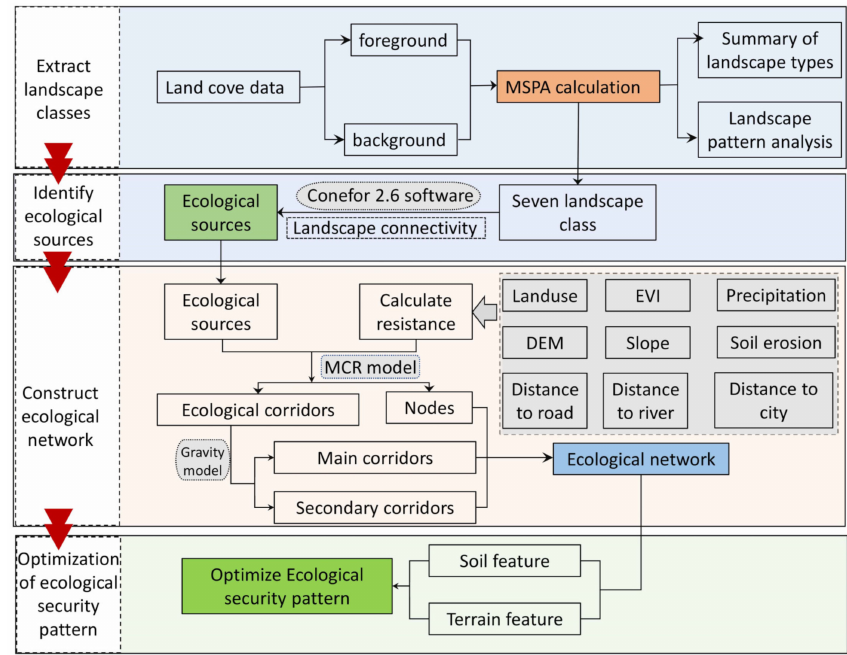
Figure 2. Research